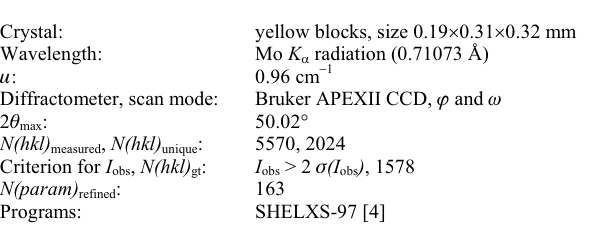
Table 1. Data collection and handling.